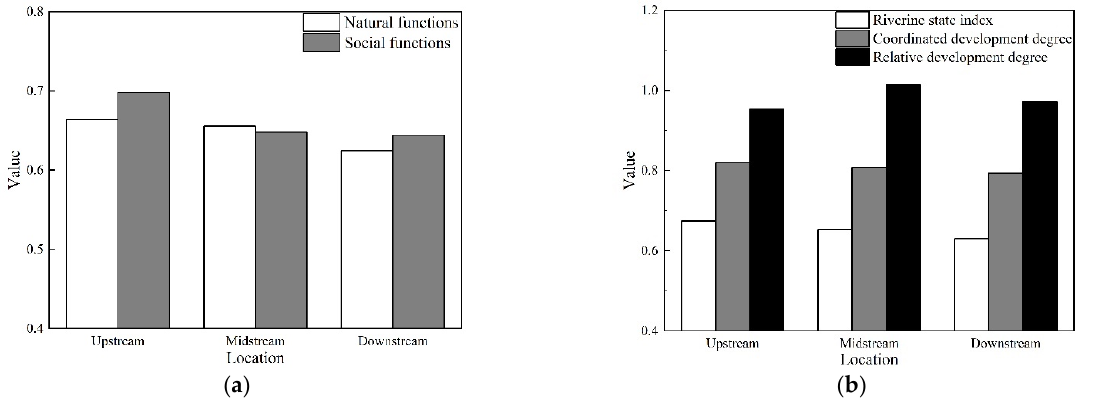
Figure 4. The overall results of the coordinated development degree assessment in the upstream, midstream, and downstream Lhasa River. The specific indicators include: ( a ) The natural and social functions; ( b ) the riverine state index, coordinated and relative development degree.